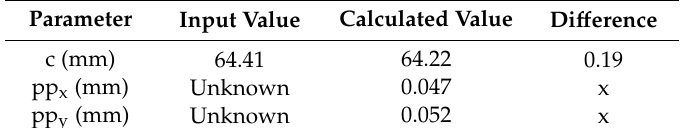
Table 1. Resulted parameters of interior orientation (camera constant c and position of principal point pp x and pp y ) by self-calibration. The calculated values are compared to the input values.